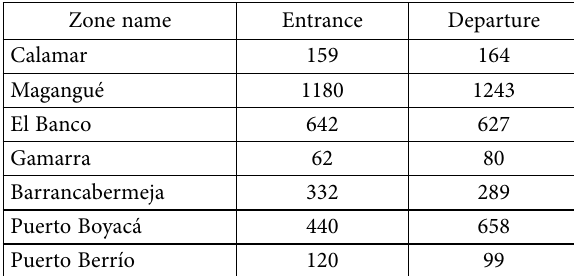
Table 1. Number of personal trips at each port per day